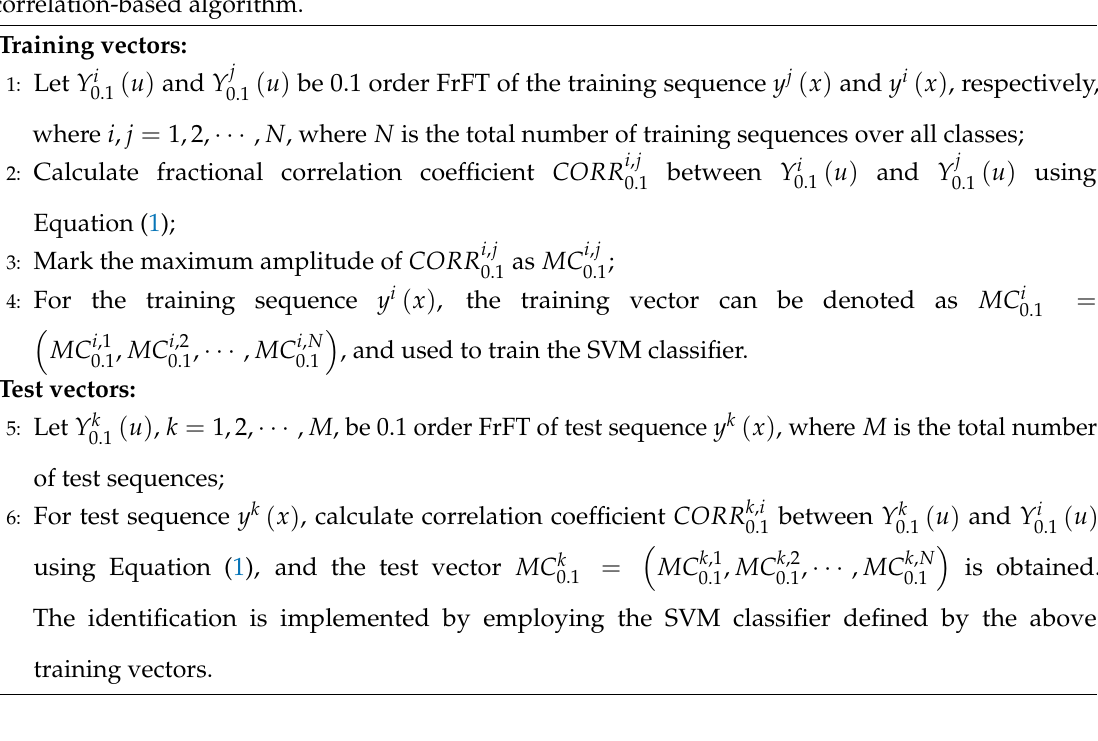
Algorithm 1 The extracting procedures for the training and the test vectors of the fractional correlation-based